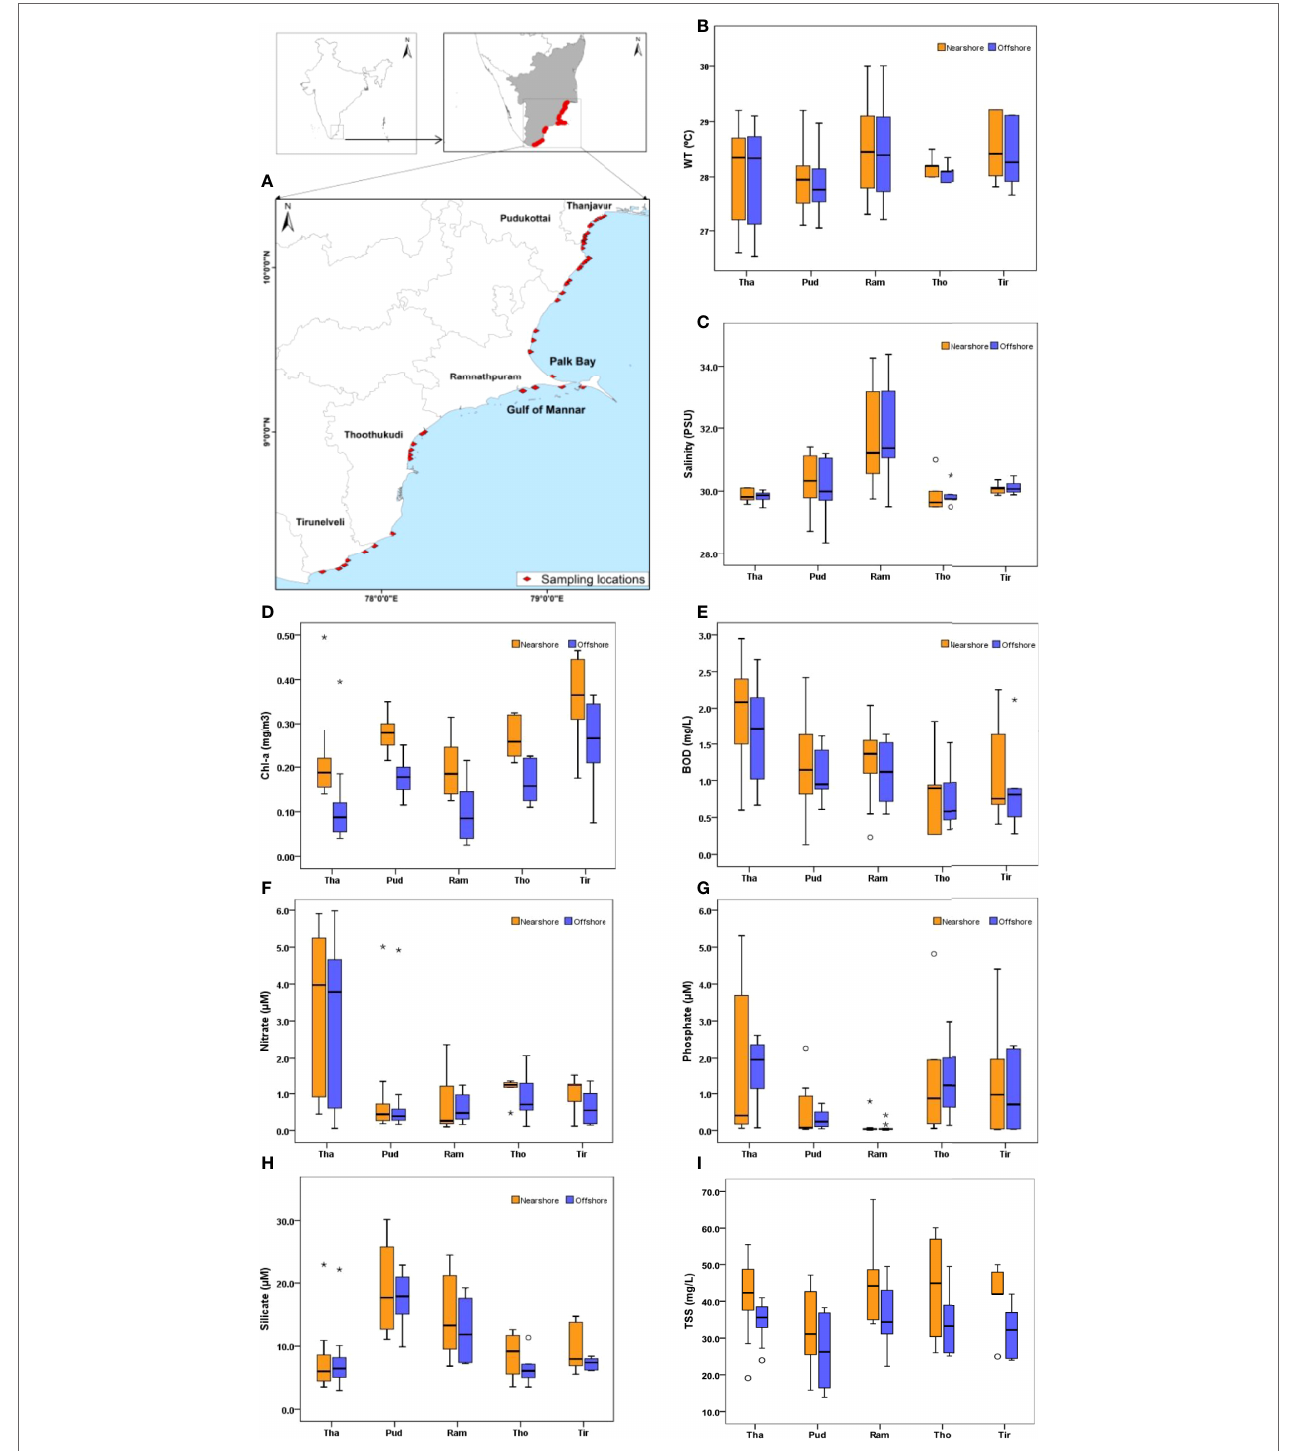
FIGURE 1 | Study area map and box-whisker plots display variations for selected physiochemical variables. (A) sampling locations, (B) WT, (C) salinity, (D) chl-a, (E) BOD, (F) nitrate, (G) phosphate, (H) silicate and (I) TSS. In each plot, the median is represented by the central point, the interval is represented by the rectangle (i.e. 25% and 75% percentiles), and range indicated by the whisker [(*: extreme outlier; ◦ : mild outlier); Sampling locations: THA, Thanjavur; PUD, Pudukottai; RAM, Ramanathapuram; THO, Thoothukudi; and TIR,